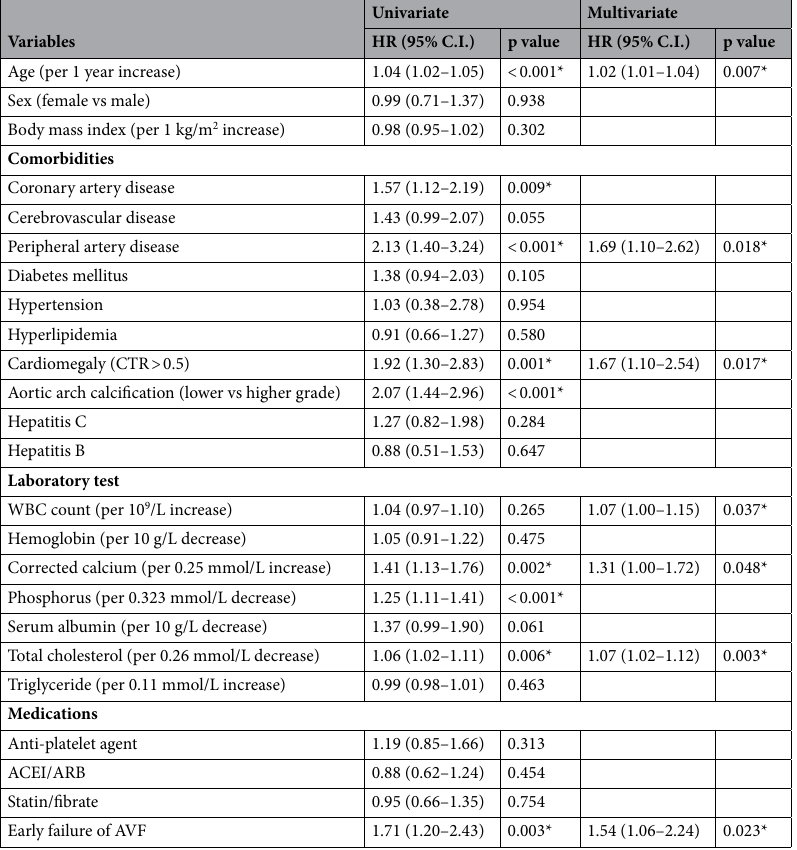
Table 2. Associated factors of overall mortality among study patients by using Cox proportional hazards analysis. CTR cardiothoracic ratio, WBC white blood cell, ACEI angiotensin converting enzyme inhibitor, ARB angiotensin receptor blocker, AVF arteriovenous fistula. *p < 0.05.